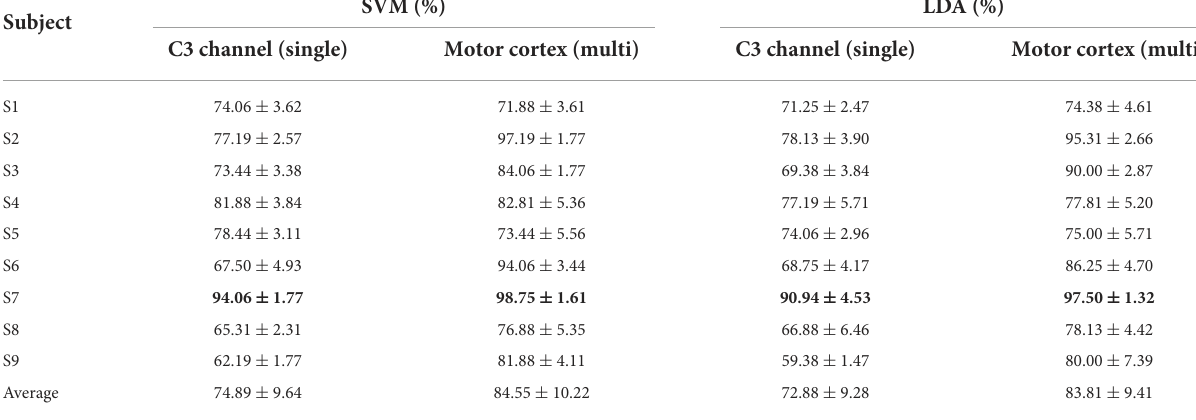
TABLE 4 Pronation vs. supination classification based on clustered features.